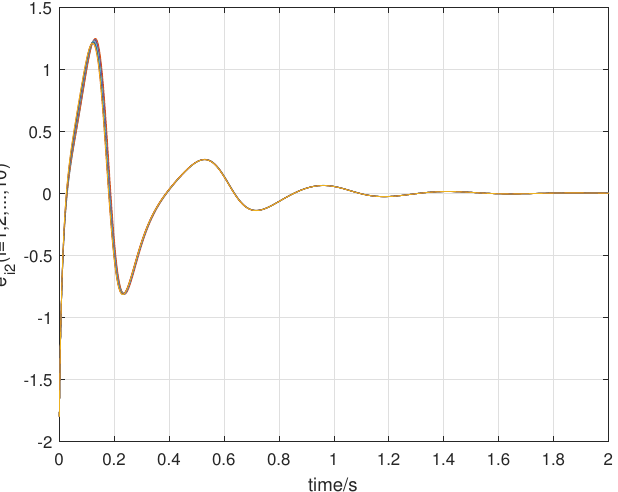
Figure 7. Trajectories of synchronization errors e j 2 ( 1 ≤ j ≤ 10 ) for the complex networks (77) and (80) with 10 fractional order nodes with time